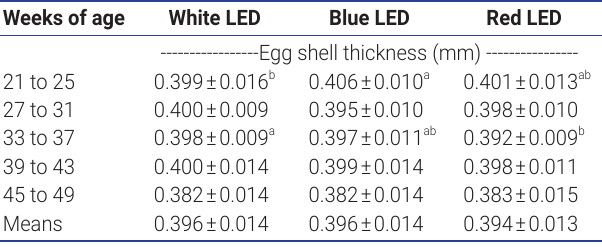
Table 6. The egg shell thickness of Brown Tsaiya ducks in different treatment groups Weeks of age White LED